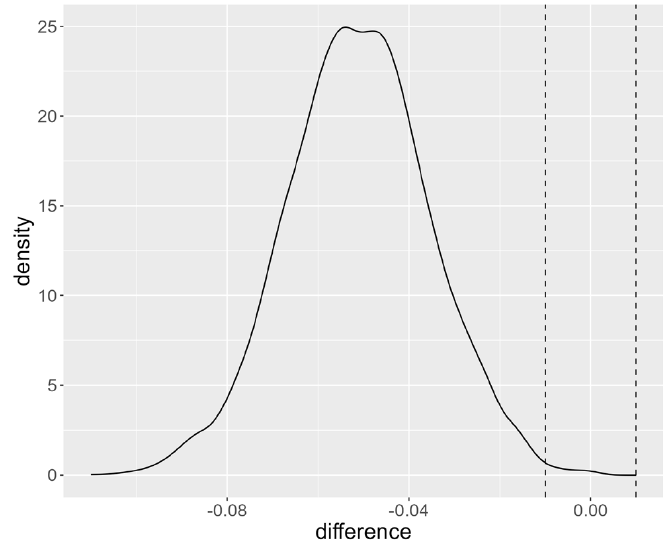
Figure 3. Posterior distribution with ROPE of the Bayesian analysis of LR and LHNLS.